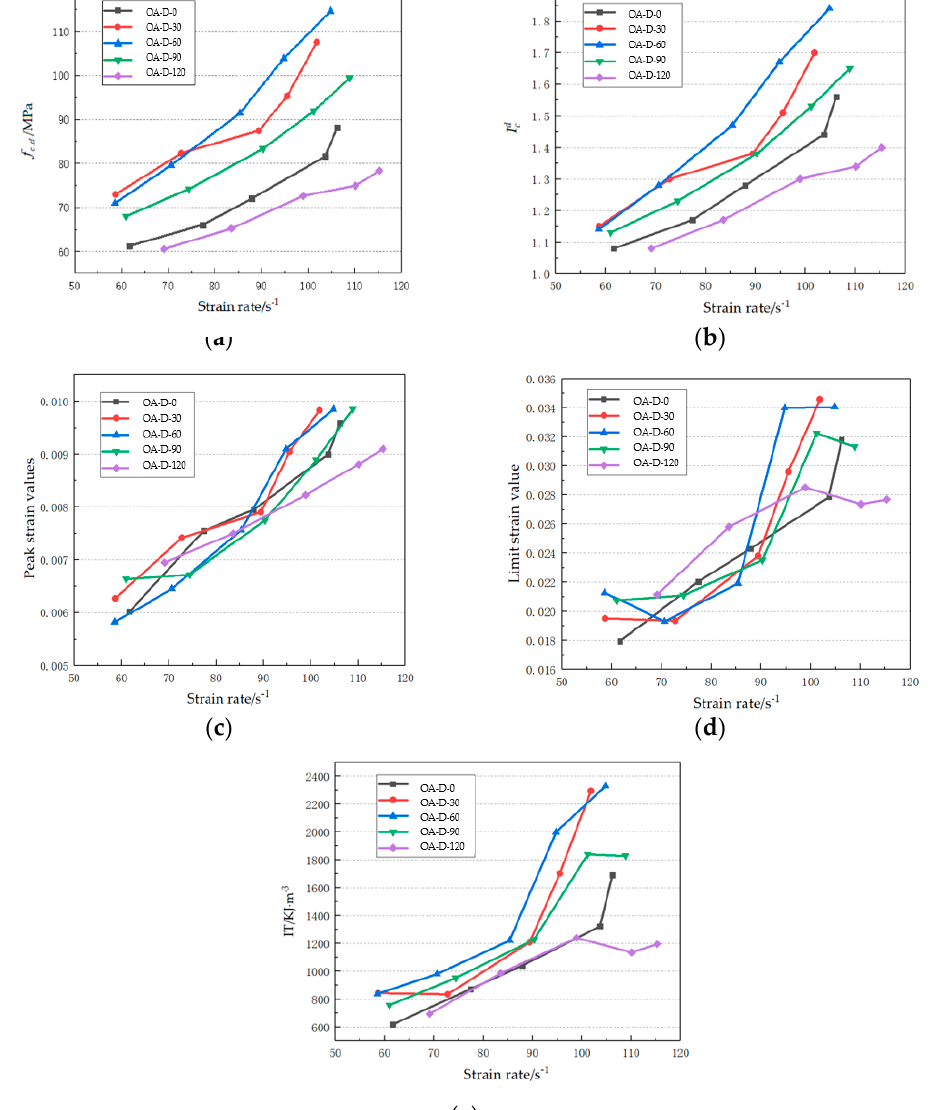
Figure 7. Dynamic mechanical related properties ( a ) dynamic compressive strengths of concrete; ( b ) dynamic strength growth factors; ( c ) peak strain; ( d ) limit strain; ( e ) impact toughness.